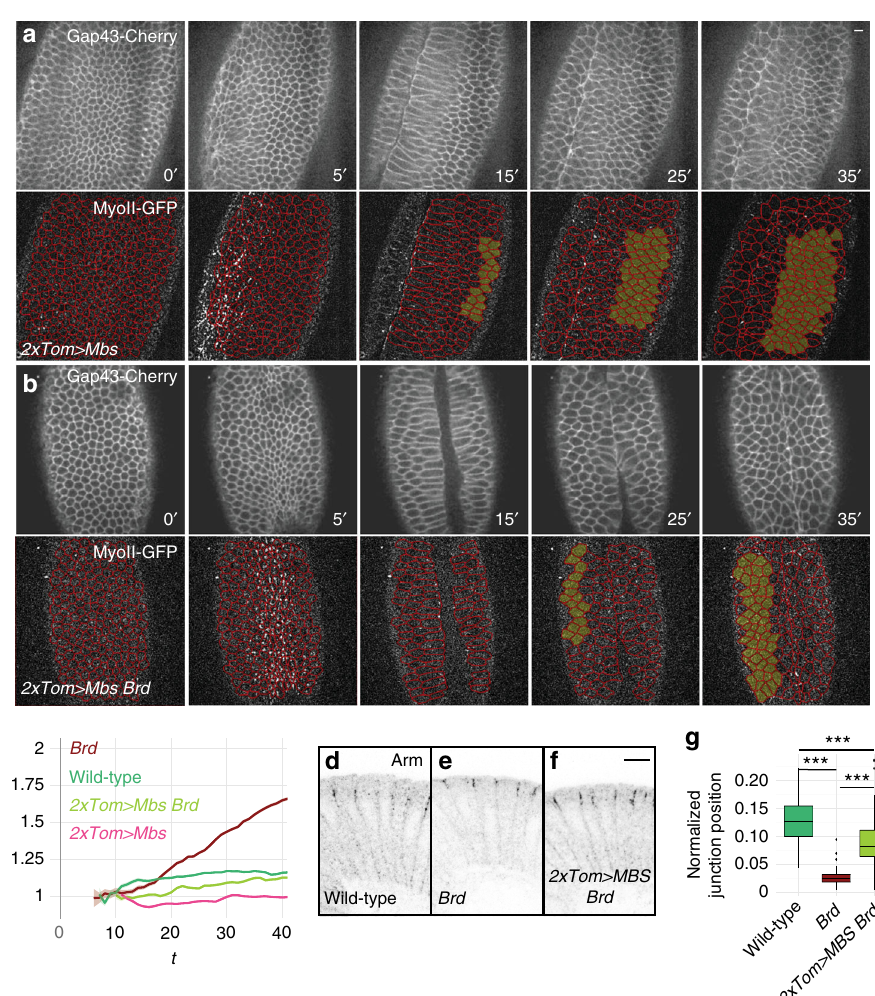
Fig. 7 Decreased contractility in the ectoderm of Brd mutants suppresses furrow unfolding. a , b Live imaging of 2x Tom > Mbs ( a ) and Brd 2xTom > Mbs ( b ) embryos expressing MyoII-GFP (bottom panels; tracking red) and Gap43-Cherry (top panels). Expression of MbsN300 in the ectoderm reduced MyoII levels in the ectoderm in both wild-type ( a ) and Brd -mutant embryos ( b ) and suppressed the Brd -mutant furrow unfolding phenotype. c Time-course accumulation of apical MyoII levels in ventral ectodermal cells of wild-type ( n = 3), Brd ( n = 3), 2xTom > Mbs ( n = 3), and Brd 2xTom > Mbs ( n = 3) embryos. Ectopic Mbs in the ectoderm reduced MyoII levels in wild-type and Brd -mutant embryos. Mean and s.e.m. values are shown (see also Supplementary Fig. 10c, d and f). d – g The position of AJs (Arm, black) along the apical – basal axis was measured in the lateral cells of wild-type ( d ; 100 junctions, 7 embryos), Brd ( e ; 65 junctions, 5 embryos), and Brd 2xTom > Mbs embryos ( f ; 85 junctions, 6 embryos) at late stage 6. As shown earlier 33 , AJ relocalize to the apical margin upon loss of Brd (as plotted in g ; p = 5 × 10 − 10 ). This phenotype was suppressed by Mbs expression in the ectoderm ( g ; p = 10 − 16